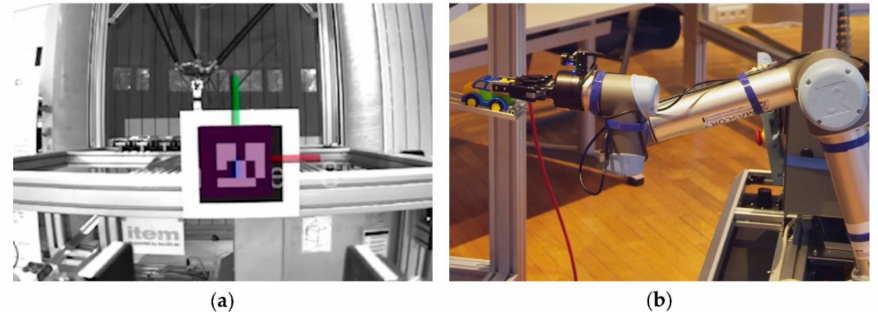
Figure 12. Grasping task based on visual servoing. ( a ) Augmented Reality (AR)-marker detection and 3D pose estimation; ( b ) grasping process of a Lego